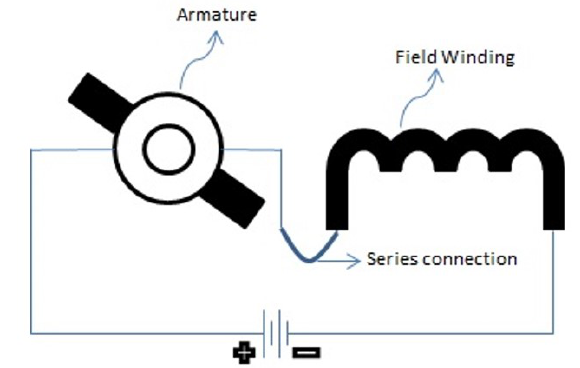
Figure 1. Series connection of a DC motor.